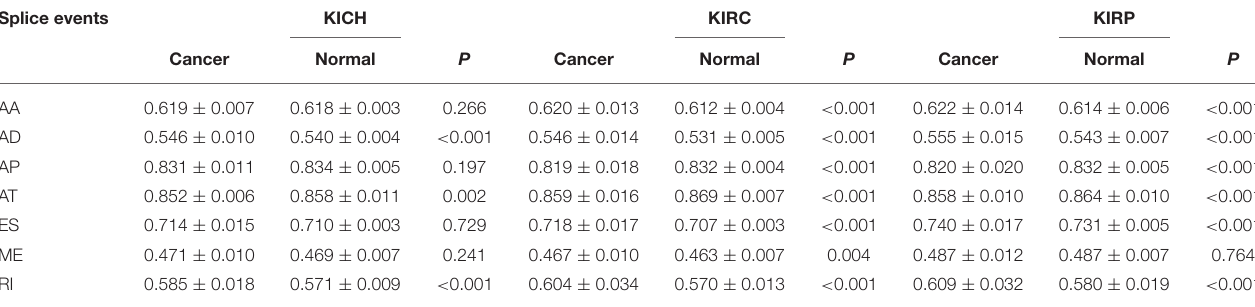
TABLE 6 | Difference of PSI value between pan-RCC and normal tissues in each type of alternative splicing. Splice events